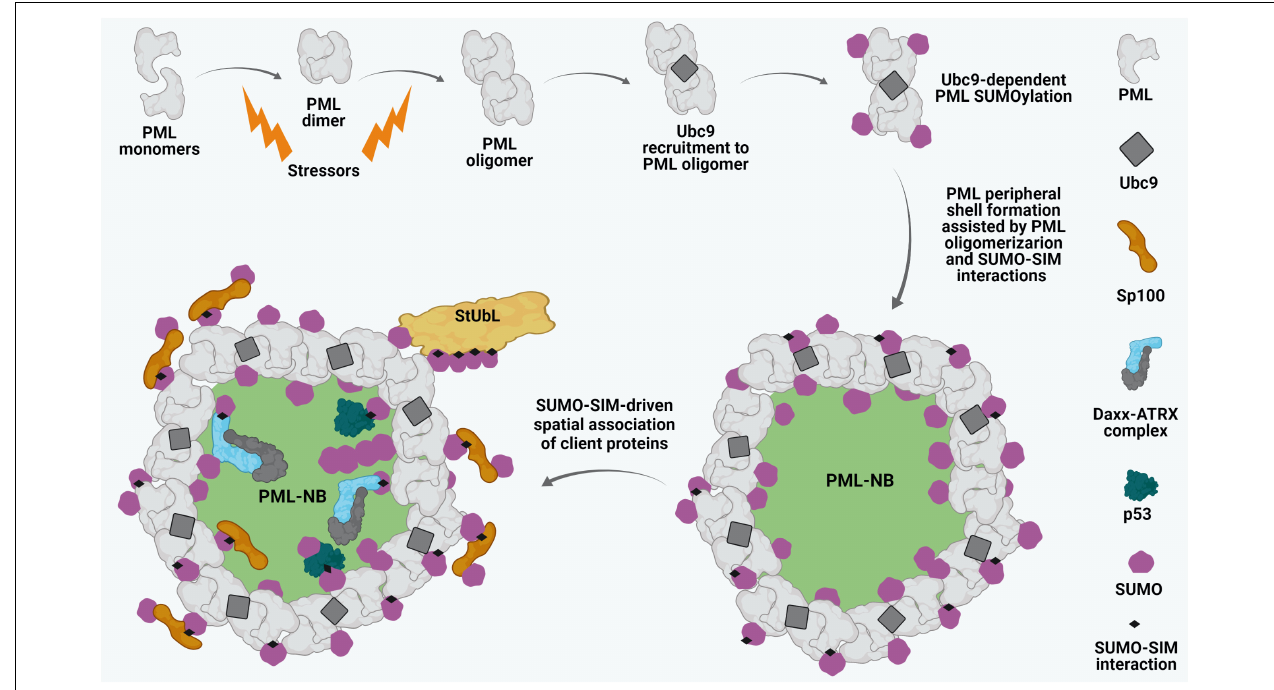
FIGURE 1 | Biogenesis of PML NBs. Oxidative stressors induce PML dimerization and oligomerization through covalent disulphide linkage and intermolecular RBCC motif-driven non-covalent interactions. Subsequently, the SUMO E2 conjugating enzyme Ubc9 is recruited to oligomerized PML and drives PML SUMOylation which further leads to stabilized PML NB shell formation. Sp100 resides along with SUMO1 at the peripheral shell. SUMO-SUMO interacting motif (SIM) affinity also enables recruitment of different client proteins such as Daxx, ATRX, p53 onto mature PML NBs. Ubc9-dependent SUMOylation of the clients may in turn regulate their dynamic interactions with the PML NBs. Poly-SUMO-primed PML might also interact with SUMO targeted ubiquitin ligases (StUbLs), suggesting crucial dynamicity of these matrix-associated sub-nuclear